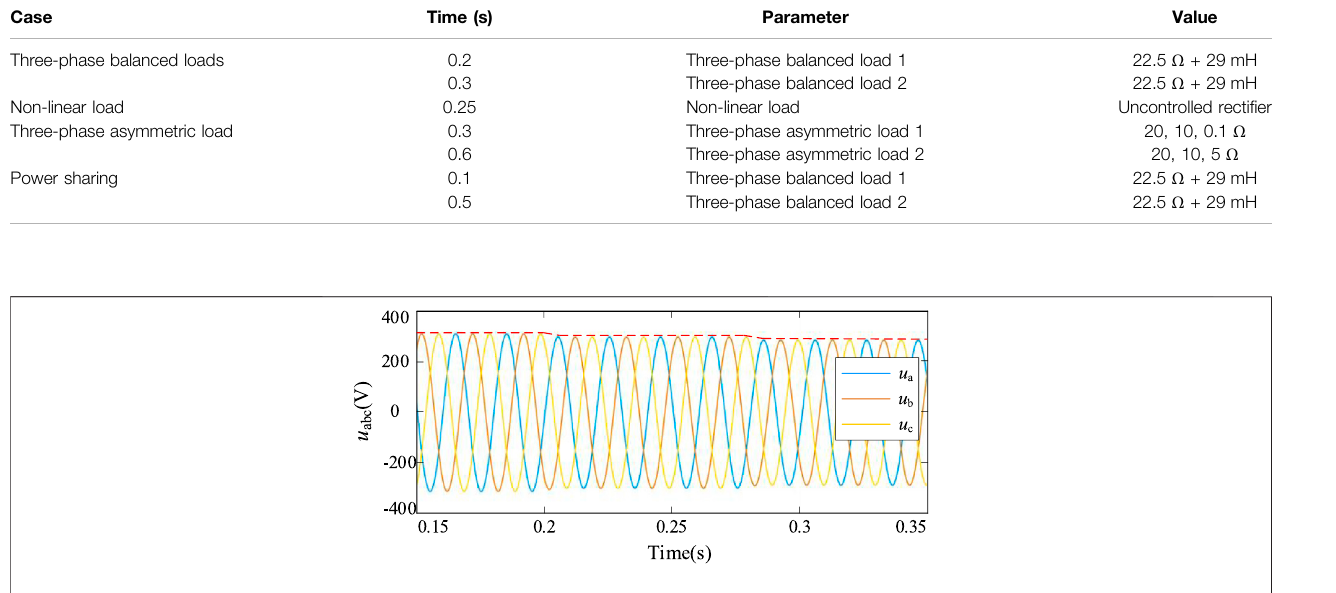
FIGURE 8 | Output voltage of the inverter under the traditional control strategy (voltage deviation).